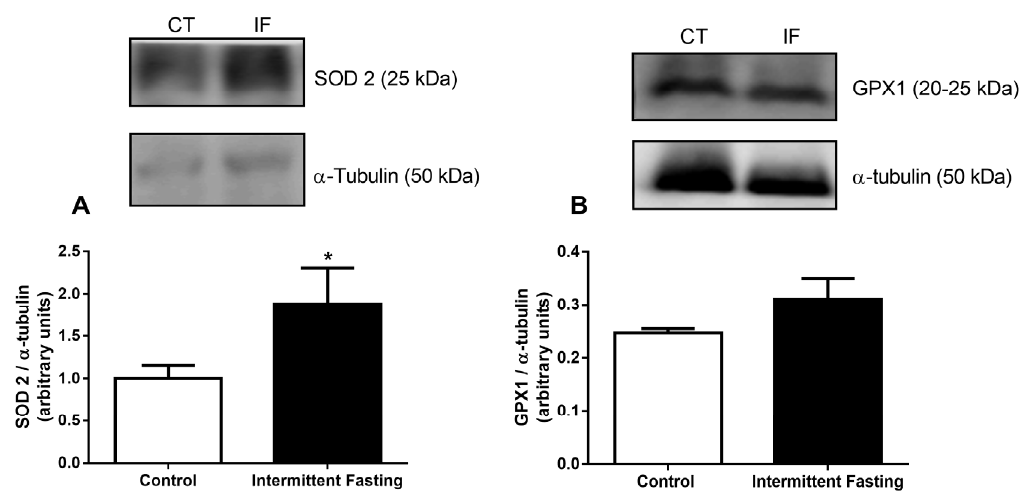
Figure 14. ( A ) Superoxide dismutase 2 (SOD2) and ( B ) glutathione peroxidase 1 (GPX1) expression of pancreatic islets isolated from Wistar rats submitted to IF for 12 weeks. The results are presented as the means ± standard error of the mean (SEM) with 5 different cellular preparations for each group. * p <0.05 compared to the control, as indicated by Student's t-test.